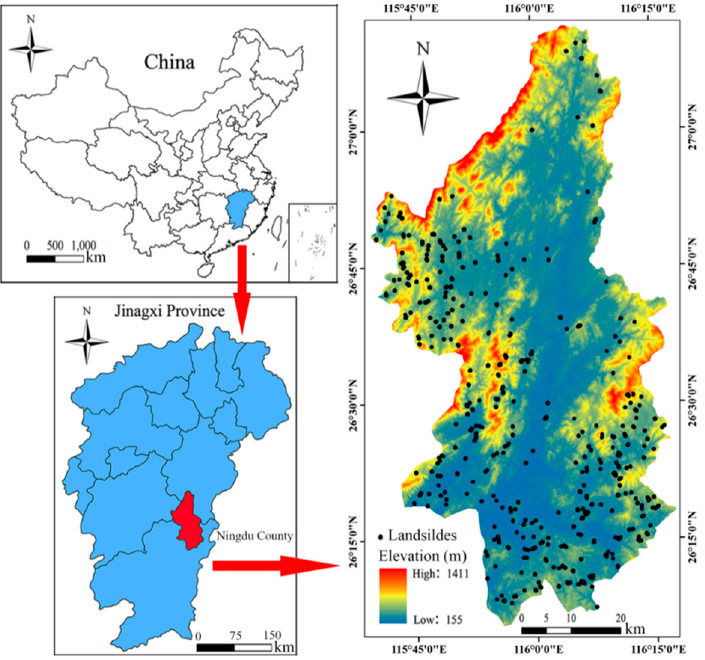
Figure 1. Location of the study area and landslide inventory.